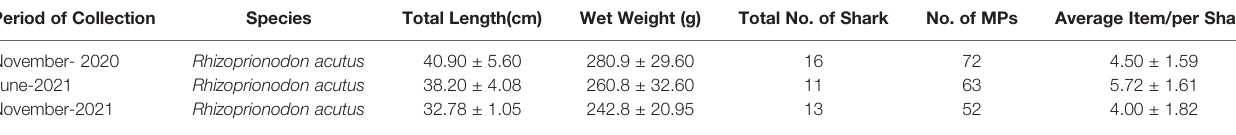
TABLE 1 | Microplastics (MPs) in shark collected from Royapuram Fish landing centre, Chennai. Period of